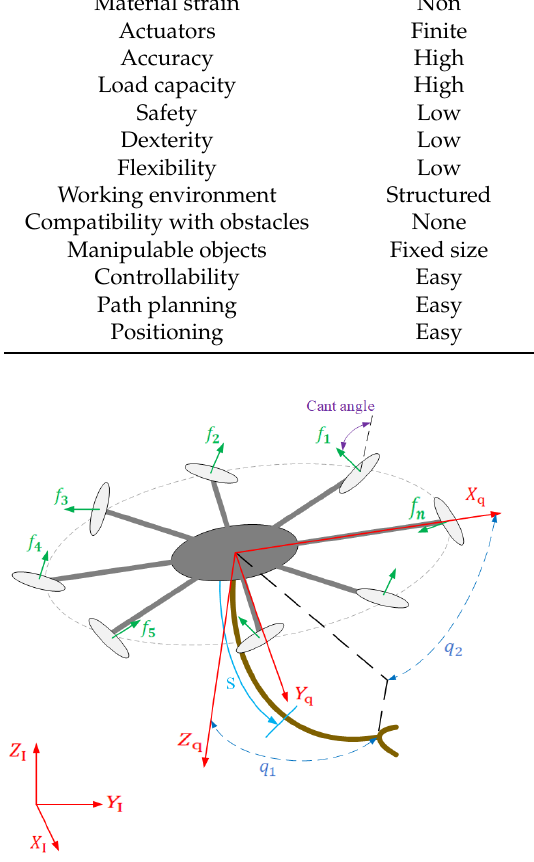
Figure 1. Schematic figure for ACMS.